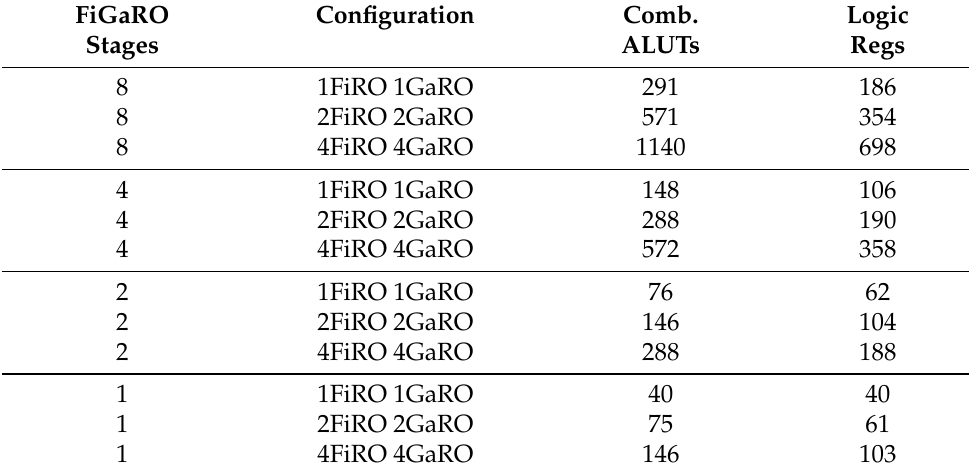
Table 4. TRNG implementation results on Stratix IV Field Programmable Gate Array